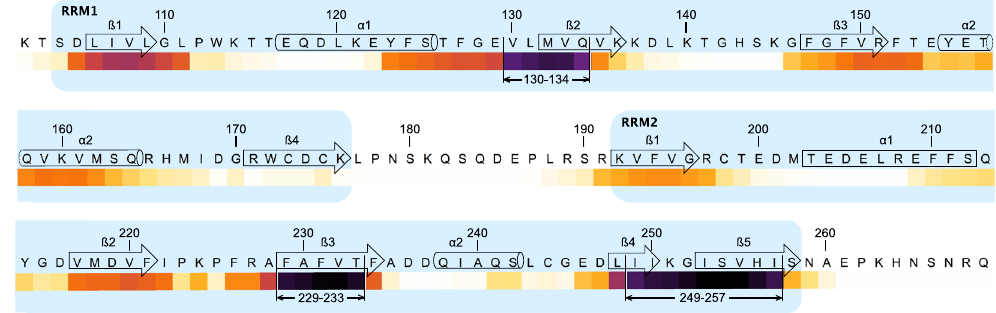
Figure 6. “Hot spots” prediction of amyloidogenic segments within TDP-43 RNA-recognition domains RRM1 and RRM2 (amino-acids 102 to 269). Amyloidogenicity prediction was performed using four independent methods i . e . Aggrescan 55 , Pasta 2.0 56 , Tango 57–59 and Salsa 60 . Results obtained from each method were standardized as a percentage considering that the maximum score given by the method was 100%. The average of the standardized percentages was calculated for each amino acid, converted in percentage, and transcribed as a “white-yellow-orange-purple-black” color scale. Amyloidogenic segments 130–134, 229–233, and 249–257 were determined setting a threshold of 80%. Secondary structures were drawn from TDP-43 structure (PDBID: 4BS2) 36 . α -helix and β -strands are schematized by cylinders and arrows, respectively, and are numbered in each RRM domain to make comparison easier with ref. 47. RRM1 and RRM2 are shown in light